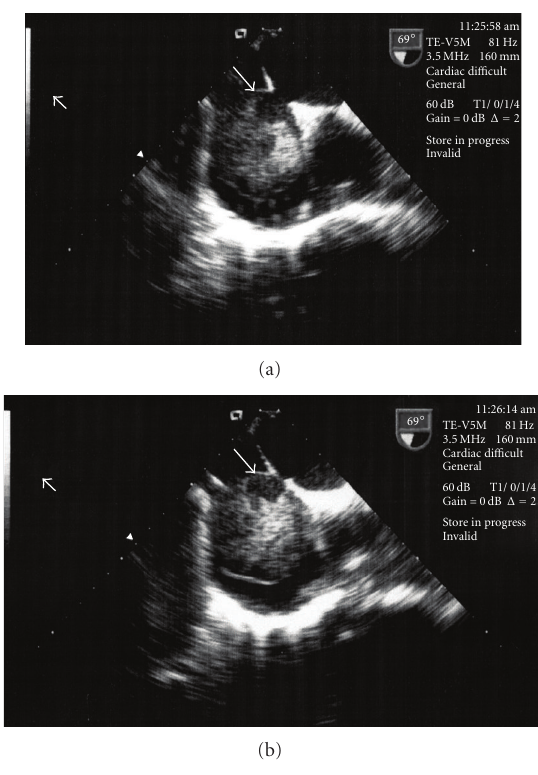
Figure 2: (a) TEE image demonstrating the detachment of part of the thrombus (arrow). (b) TEE image demonstrating the detachment of part of the thrombus (arrow).